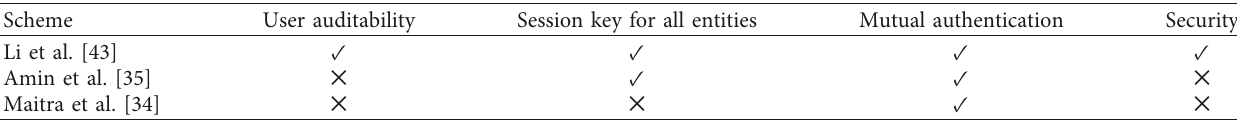
Table 7: Performance evaluation.